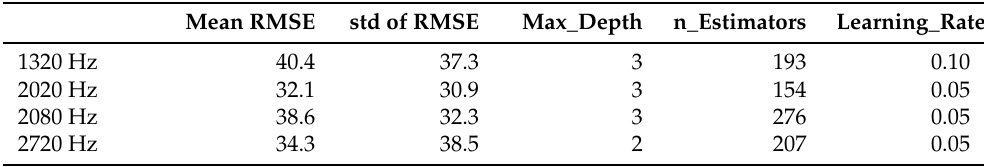
Table 3. The results of parameter tuning of the XGBoost regression model for predicting H m 0 , done by grid